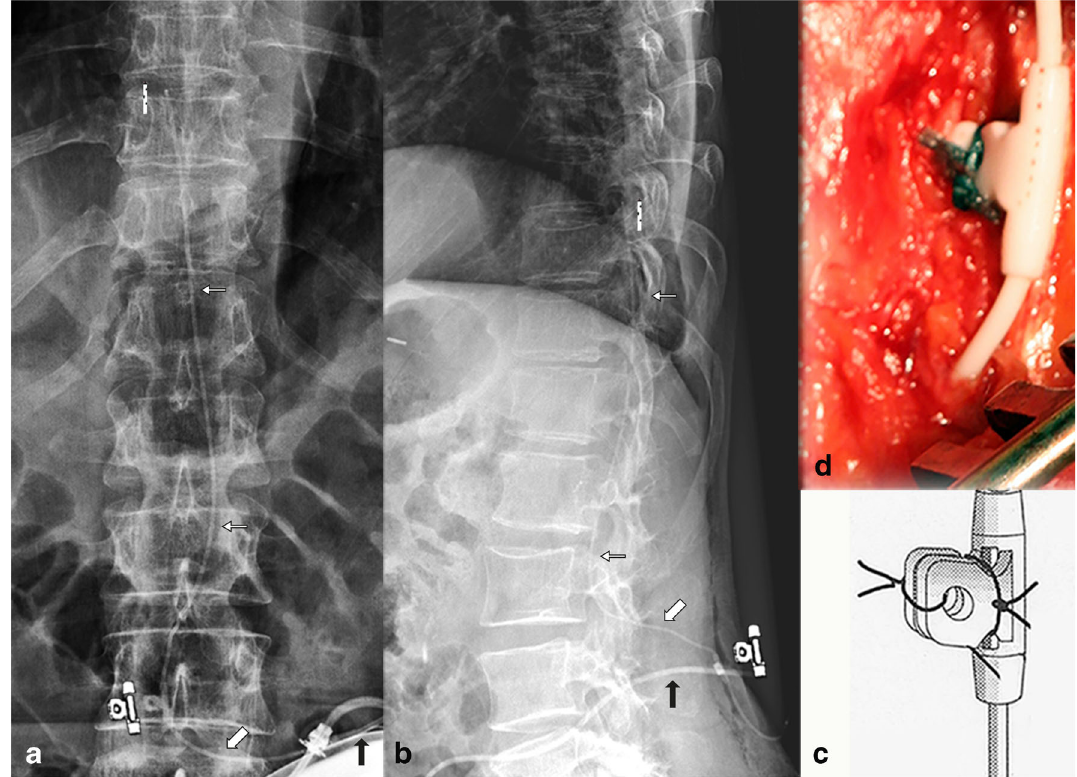
Fig. 2 Anterior-posterior ( a ) and lateral ( b ) plain radiography of the lumbar spine, in vivo image ( d ) and artist rendering ( c ) of the typical folded fixation anchor (with anchor symbol ), large diameter catheter